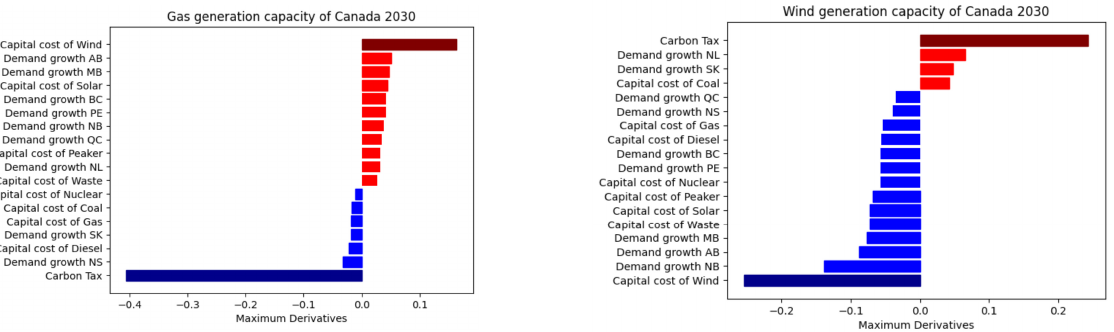
Figure 6. National Gas and Wind Generation Capacity in 2030. Ranked factors affecting Canadian gas and wind generating capacities in 2030 are presented in bar charts. These are quantitative measures of the relative impact of system inputs on two key components of the Canadian energy supply mix, with the parameters listed on the y -axis. These values, which show correlation intensity, are normalized maximum derivatives of gas and wind capacities with respect to each input on the y -axis. The negative values show the negative correlations, positive values show positive correlations, and the absolute values of maximum derivatives represent the correlation intensity.